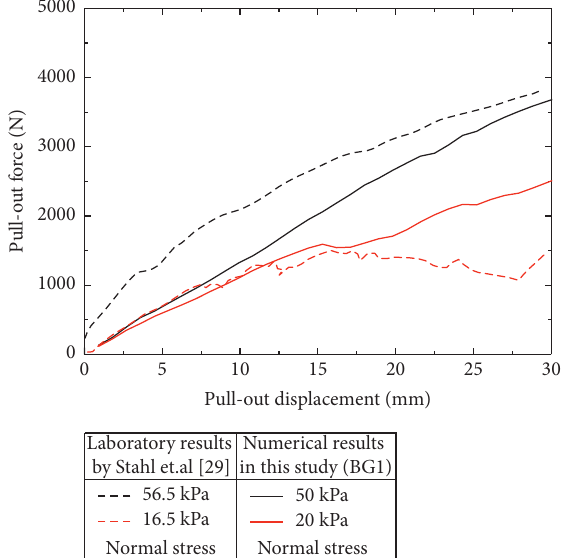
Figure 5: Comparison of laboratory test and numerical simulation